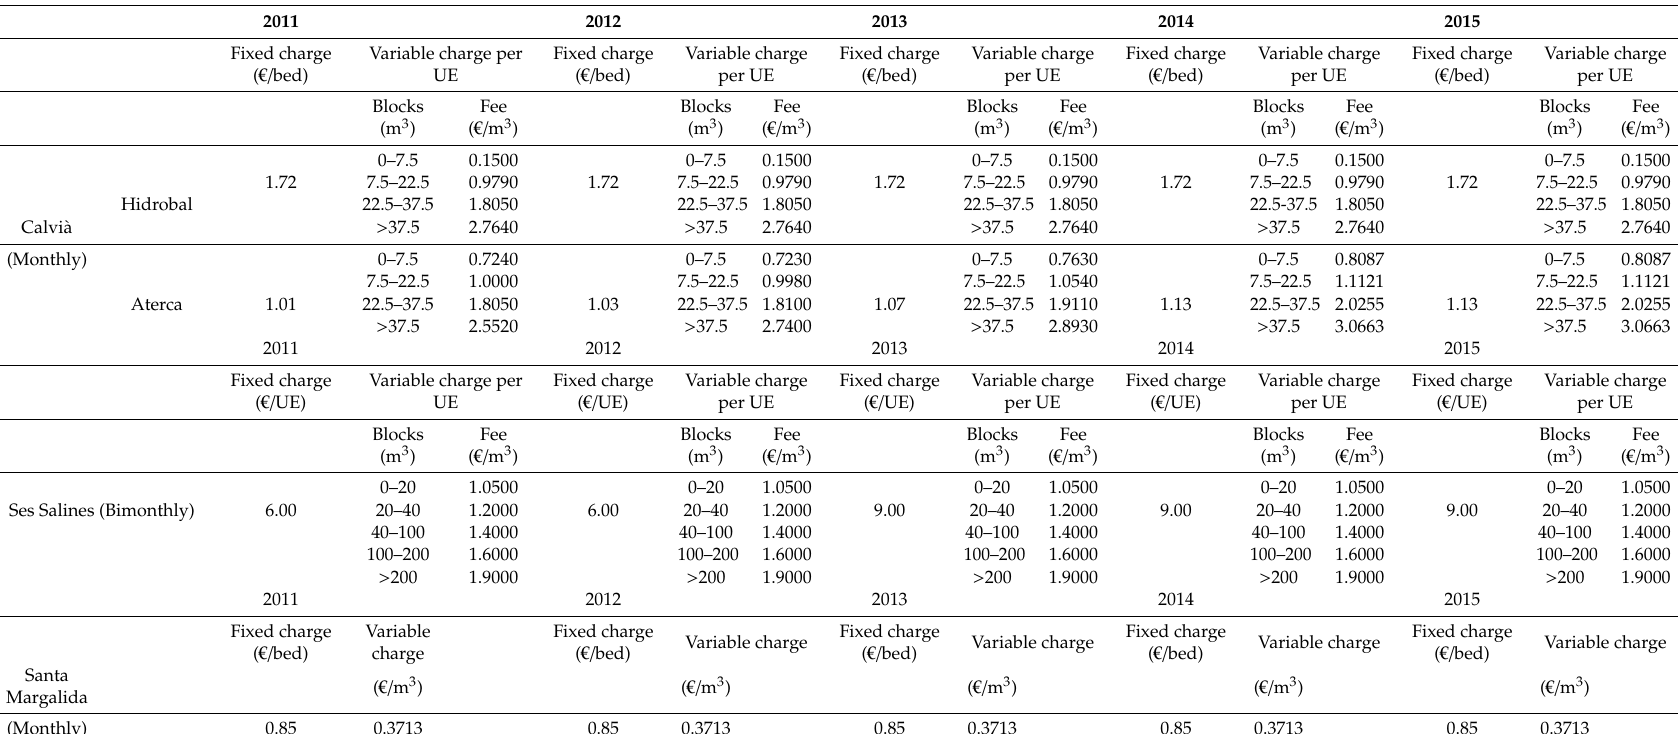
Table 1. Water supply tari ff s per municipality and